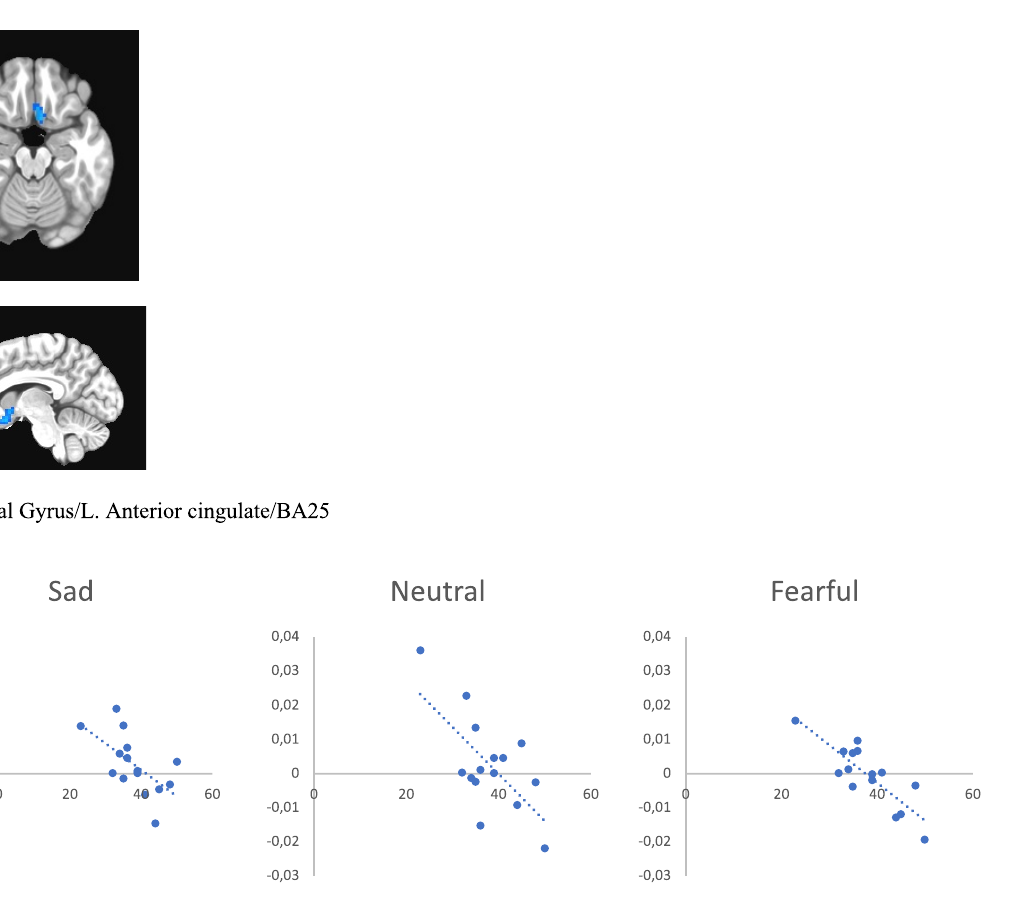
X Y Z (Local peak activation) BA 11 Left medial frontal gyrus BA25 Left anterior cingulate